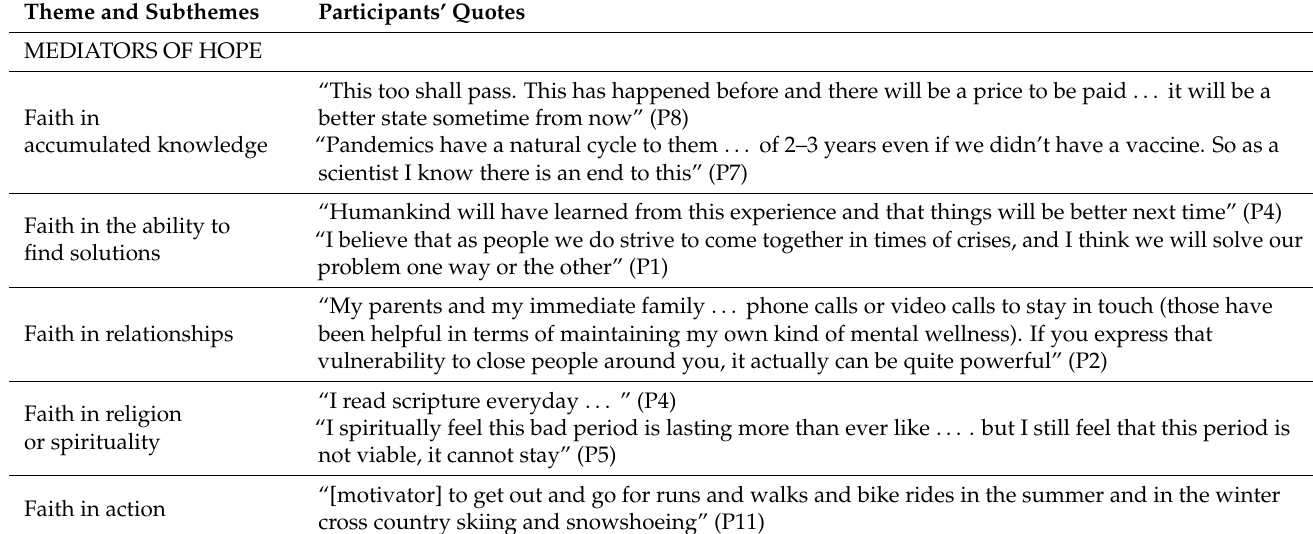
Table 4. Overarching theme, subthemes, and key quotes highlighting the coping strategies used by the physicians to adapt to the COVID-19